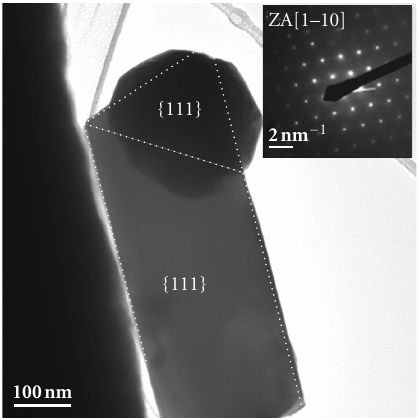
Figure 2: 65 ◦ tilt view SEM image of a Si substrate covered with Au evaporated at room temperature and Ge evaporated at 480 ◦ C. The sample is oxygen-free.